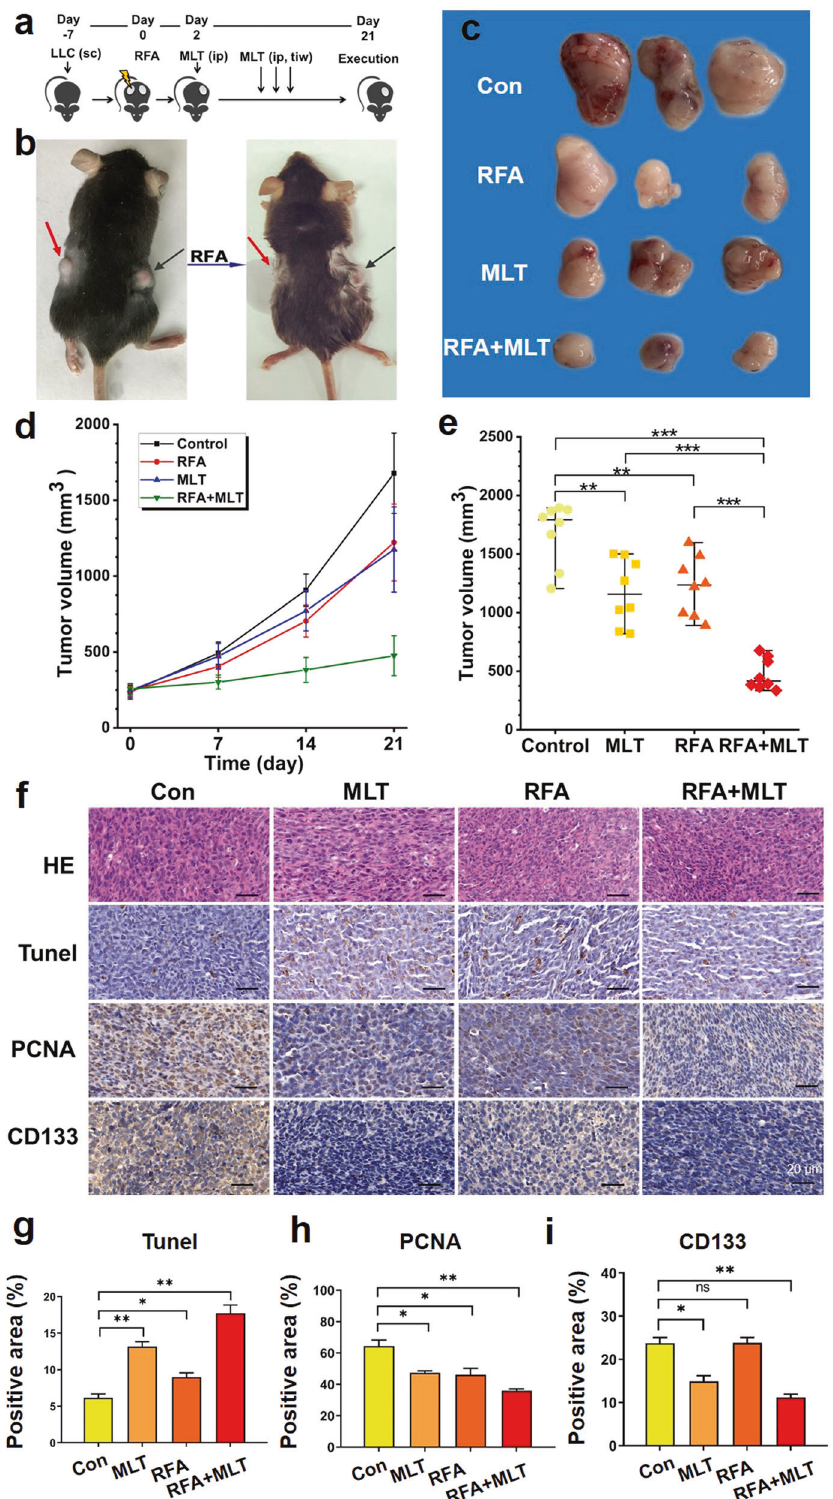
Fig. 2 RFA + MLT treatment signi fi cantly inhibited tumor growth in non-ablated zone. a Experimental design of studies in C57BL/6 mice. Time in days relative to tumor treatment with radiofrequency ablation. b C57BL/6 mice were subcutaneously injected in bilateral fl anks with Lewis lung cancer cells, and unilateral Lewis cancer cells were treated with radiofrequency ablation (red arrow for non-ablated zone in right and black arrow for ablated zone). c Images of tumor tissues after treatment with RFA, MLT, and RFA + MLT for 21 days. d Tumor volume after treatment with RFA, MLT, and RFA + MLT at different days. e Tumor volume after treatment with RFA, MLT, and RFA + MLT in 21 days. f Expression of HE, TUNEL, PCNA and CD133 in non-ablated tumor tissue samples (scale bar = 20 μ m). The bar graph showed the level of g TUNEL, h PCNA, and i CD133 in non-ablated tumor tissue after treatment with MLT, RFA, and RFA + MLT, respectively. (* P < 0.05; ** P < 0.01; *** P < 0.001) Signal Transduction and Targeted Therapy (2021)